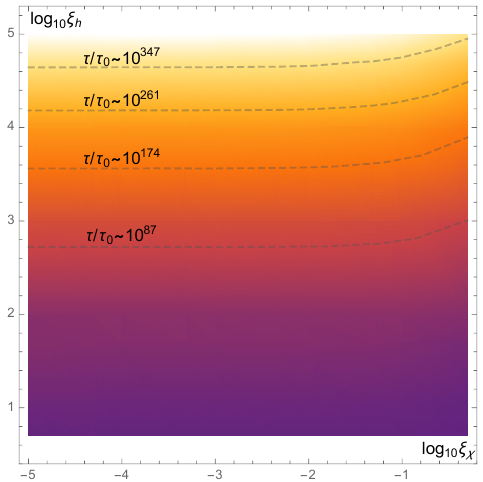
Figure 5. The ratio of the life-time of the Universe in the Higgs-Dilaton model ( (cid:28) ) to that in the SM ( (cid:28) 0 ). Here we choose m t = 173 : 34 GeV and ^ (cid:22) = ^ (cid:22) I